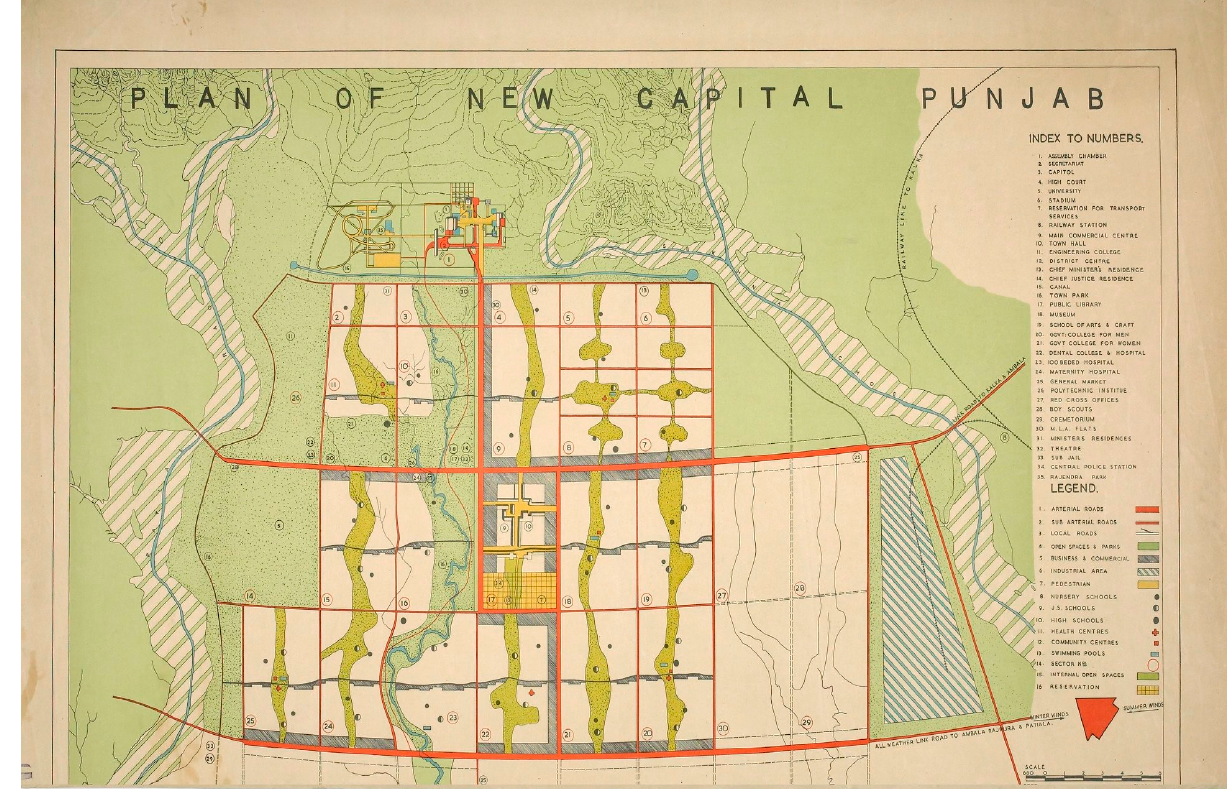
Figure 7. Chandigarh’s Master Plan. FLC05553. Source: © FLC/ADAGP .